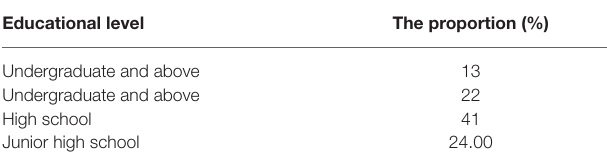
TABLE 4 | Educational composition of